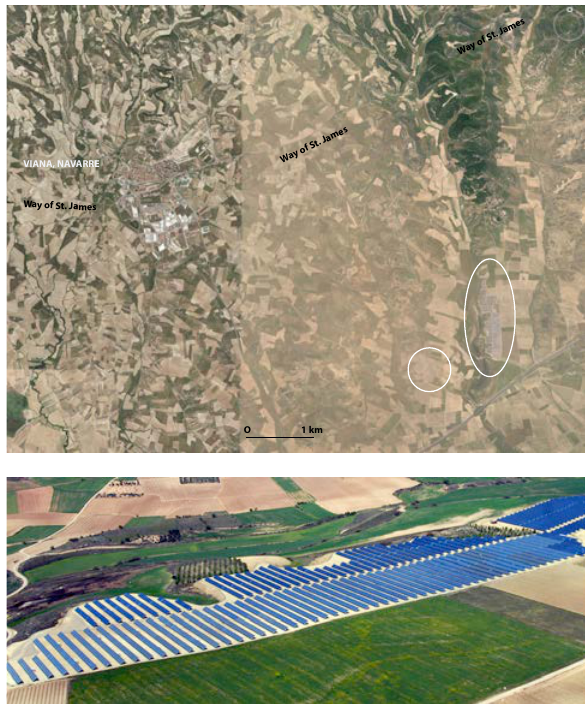
Figure 1. Solar photovoltaic facility in Viana (Navarre, Spain): an example of a carefully planned location that avoid the visual impact from the Way of St. James. The white ellipses show both